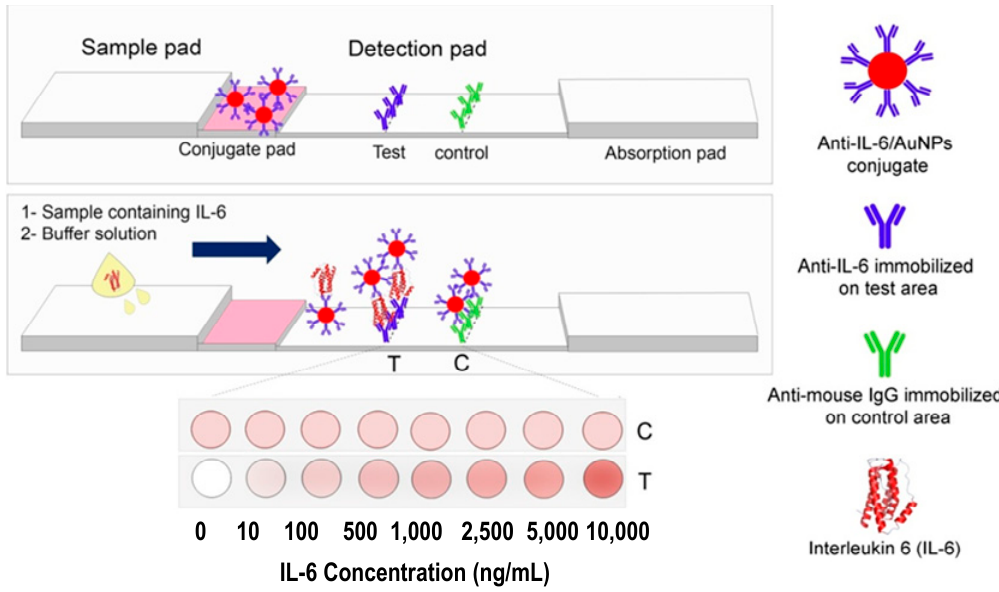
Figure 7. Scheme of IL-6 detection by LFIA. Reproduced with permission from [31].